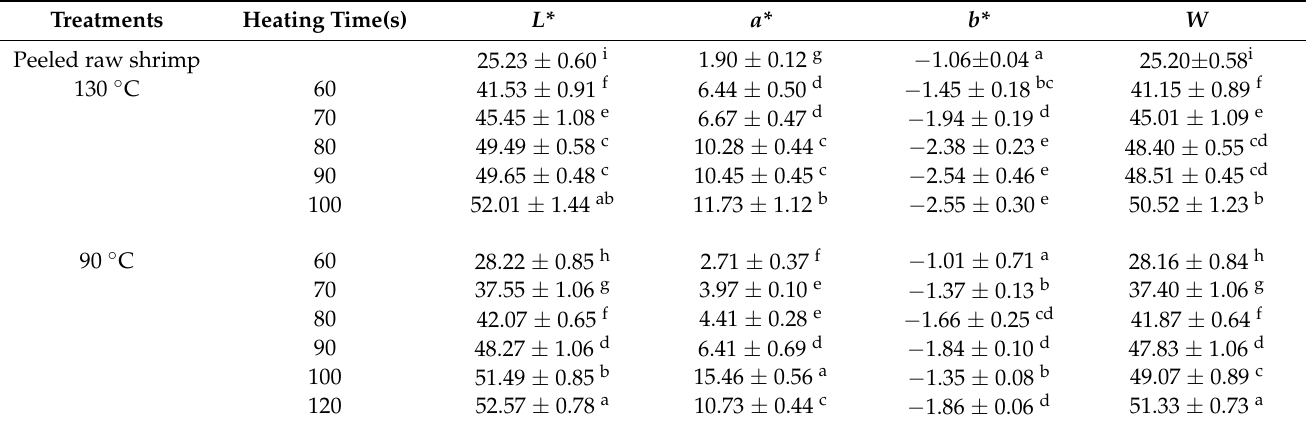
Table 3. Changes in color ( L* , a* , b* , W value) in peeled white shrimp using microwave-assisted induction heating (MAIH) system set at 130 and 90 ◦ C for different heating